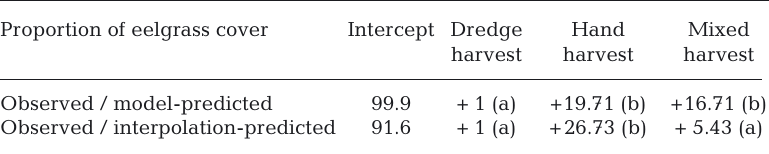
5. Coefficients from mixed effect models using restricted log-likelihood and Tukey’s post hoc test (small letters in parentheses) to compare harvest methods. Dredge harvest beds had significantly lower proportions of actual to model and interpolation-predicted Zostera marina than hand-harvested beds. However, dredge harvest beds had 100% of the model-predicted and 92% of the interpola- tion-predicted Z. marina , while hand-harvested beds had 120% and 127% of the model- and interpolation-predicted amount of Z. marina cover,